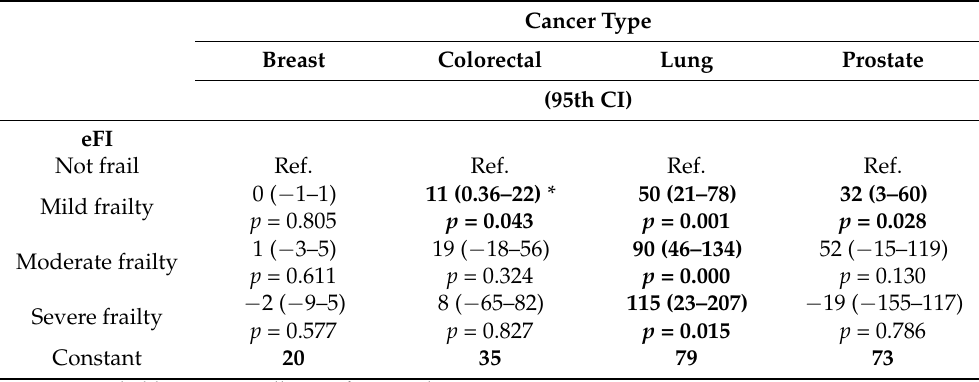
Table 4. Median time to diagnosis (days) by level of frailty, stratified by cancer